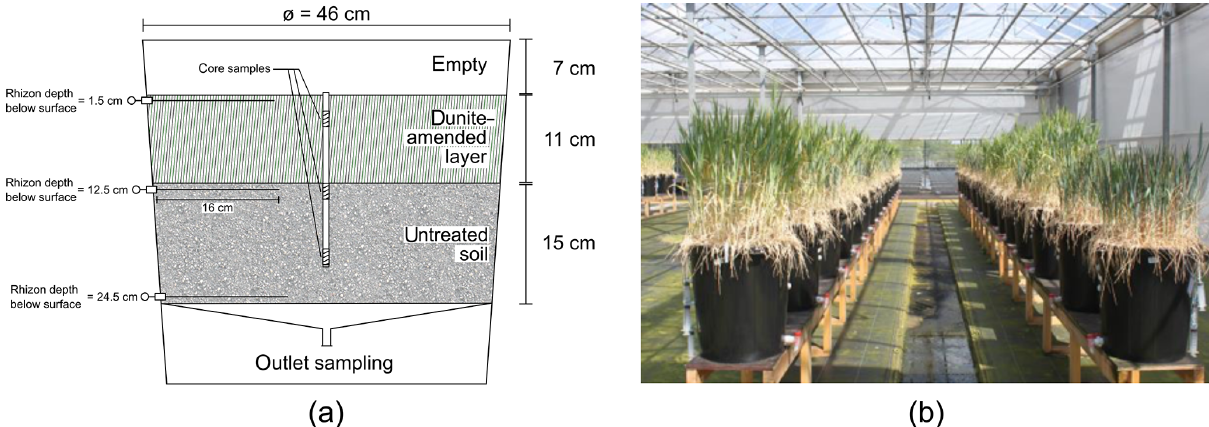
Figure 1. (a) Schematic mesocosm configuration; (b) status of the experiment in April 2014 (6 months in). Table 2. Specific surface area of the source material, derived by BET analyses, as well as grain size distribution characteristics. Grain size Specific surface Specific surface p80 a Dominating Share of Smallest Share of category area, N based area, Kr based (µm) class b dominating class smallest (m 2 g − 1 ) (m 2 g − 1 ) (µm) class (%) (µm) class (%) Fine 9 . 53 ± 0 . 43 14 . 75 ± 0 . 24 43.5 25.5 6 . 7 ± 0 . 02 < 0 . 9 c 2 . 66 ± 1 . 51 Coarse 1 . 06 ± 0 . 10 1 . 61 ± 0 . 03 1020 720 10 . 8 ± 0 . 7 < 18 1 . 51 ± 0 .